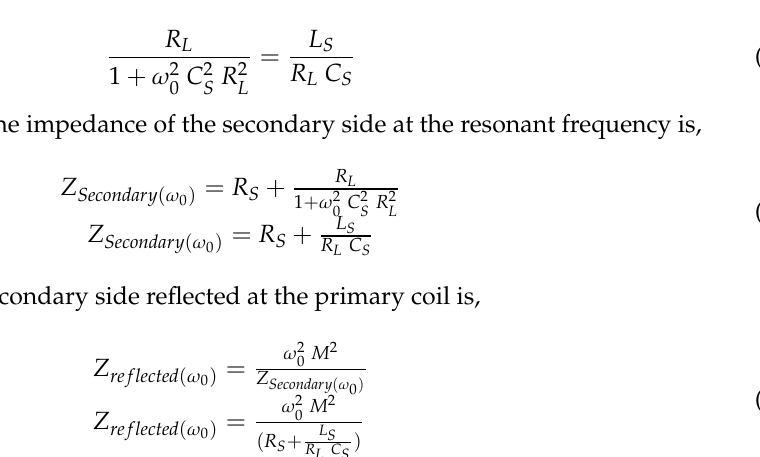
Figure 3. The circuit schematic for the analysis of load-shift keying data modulation is shown. L P shows the primary coil matched to 50 Ω with C P1 and C P2 , and L S presents the secondary coil with the resonant capacitor of C S .